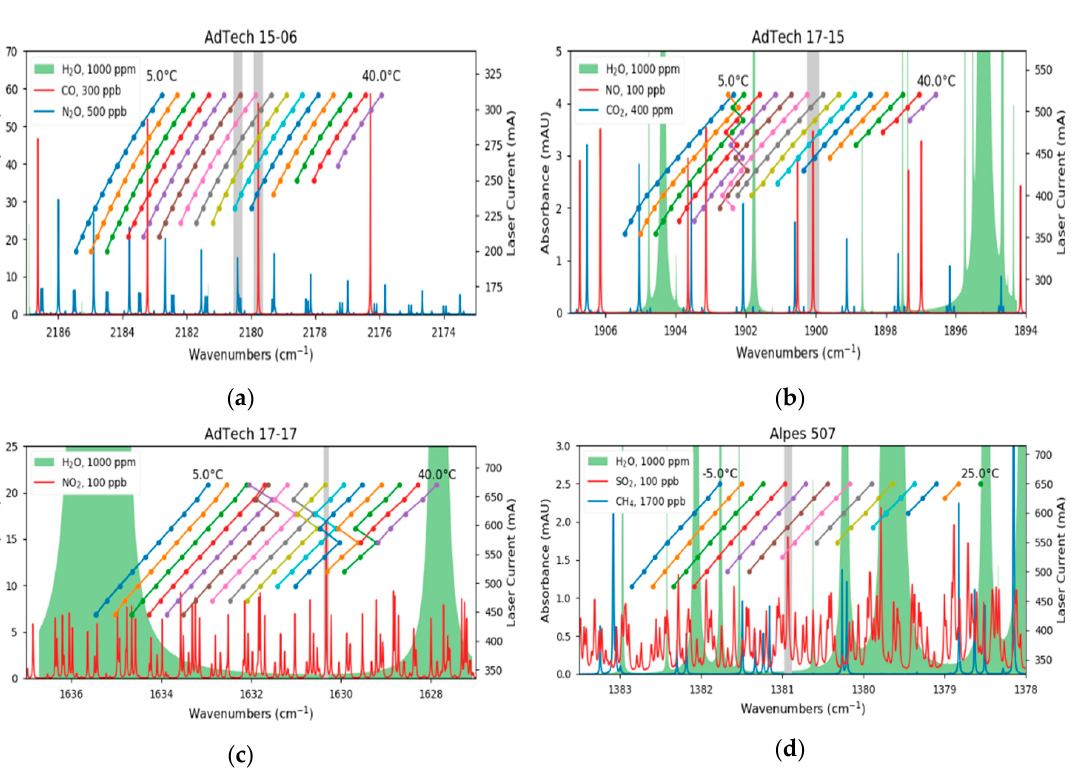
Figure 2. Characterization of the cw-QCLs. While the lasers for CO ( a ) and SO 2 ( d ) are mode-hop-free, the devices for NO ( b ) and NO 2 ( c ) have mode-hops within their operation range. In addition, absorption spectra of the analytes and other interfering species are plotted. The grey sections indicate the investigated absorption lines of the analytes.